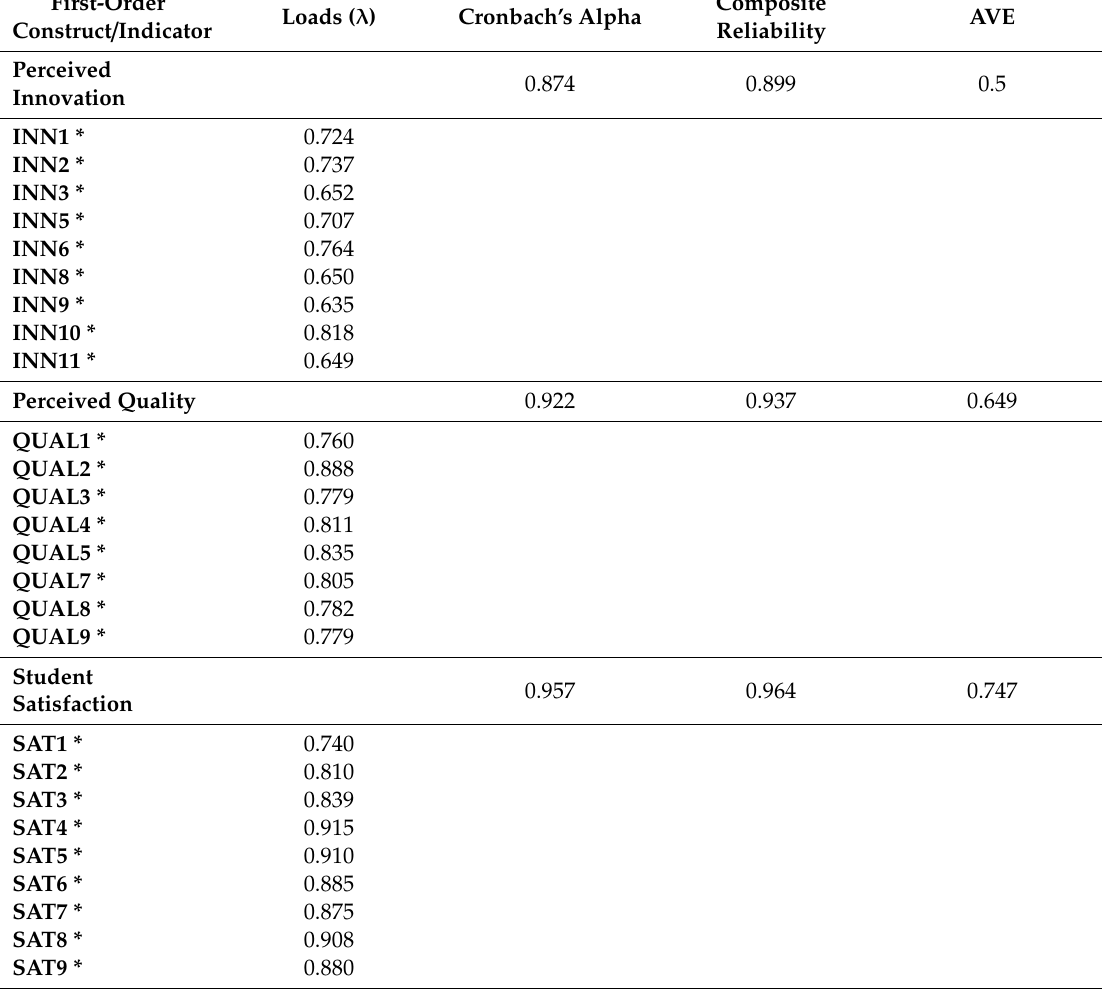
Table 6. Items’ individual